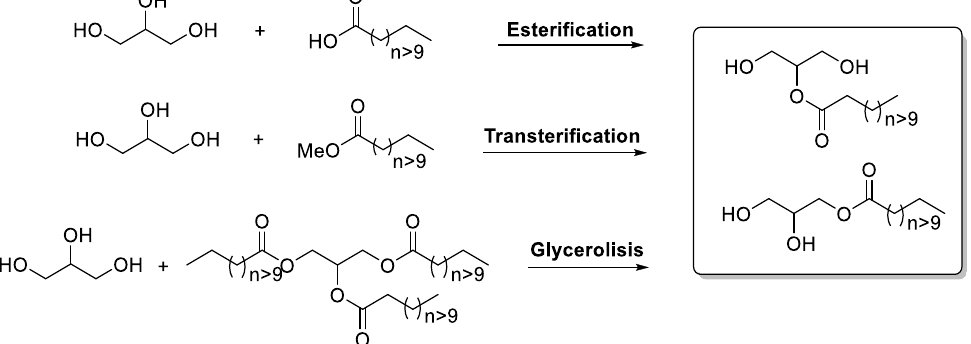
Scheme 1. Glycerol conversion into